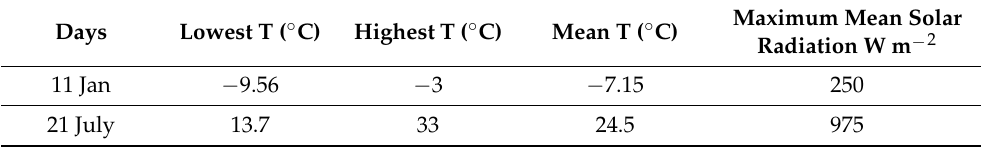
Figure 7. House plan for the ground floor and the first floor. Table 3. Climatic characteristics of the coldest and hottest